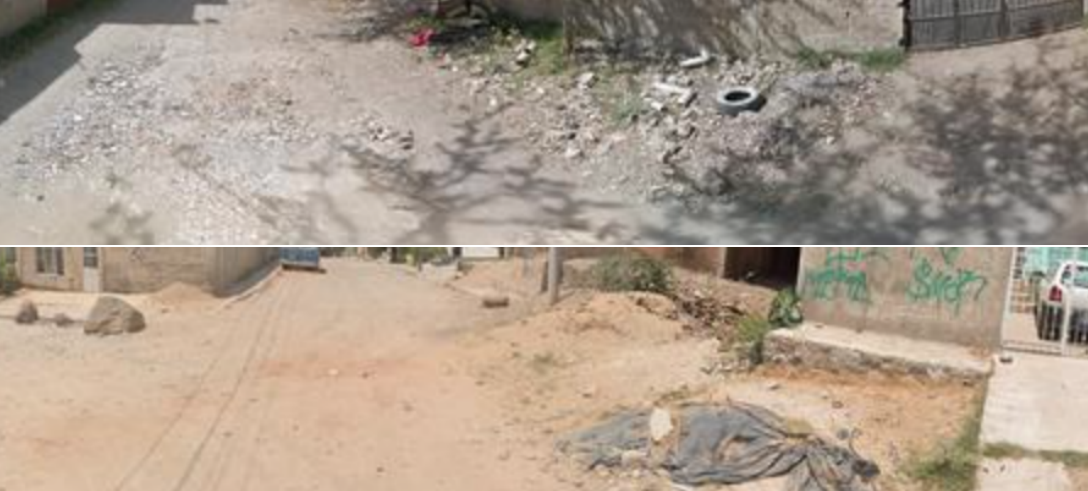
Figure A1. Impoverished.